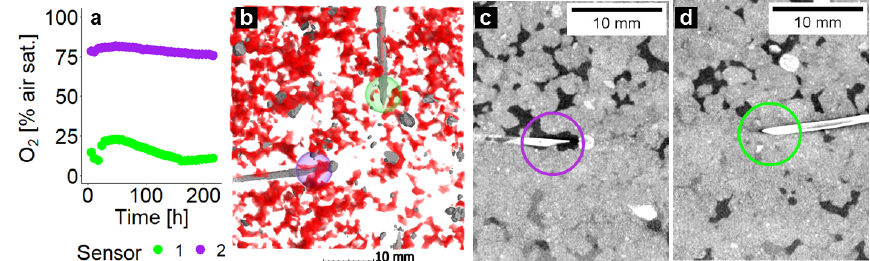
Figure 5. Local oxygen distribution in one soil core packed with small aggregates (2–4mm) from Gießen soil (GI) incubated at 75% water- filled pore space (WFPS) to illustrate as an example the very local measurement of O 2 . Shown here are (a) O 2 saturations measured by two microsensors as a function of incubation time; (b) a 3D subvolume shown from the top, with connected air depicted in red and both sensors depicted with their respective spherical support volume in colours corresponding to (a) ; and 2D greyscale slices through the sensor tip depicting soil matrix in light grey, water in dark grey, and air in black for (c) the sensor measuring high and for (d) the sensor measuring low O 2 saturations. The violet and green circles depict the proximity of the sensor tip (7.2mm diameter) used to calculate the averaged local metrics.